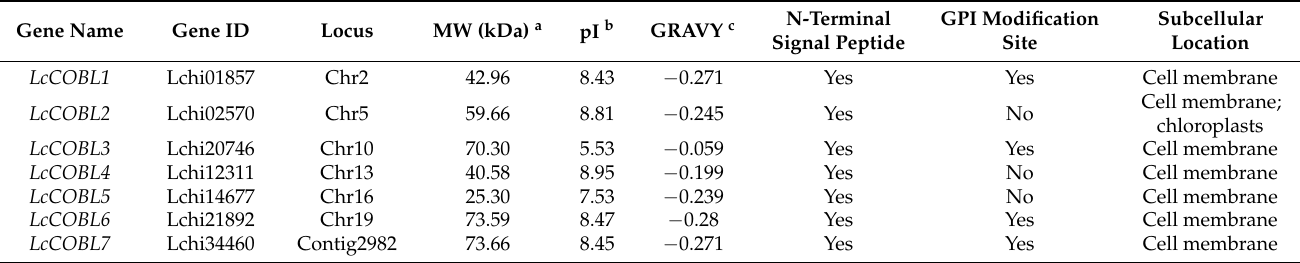
Table 1. List of gene IDs and characteristics of the LcCOBL